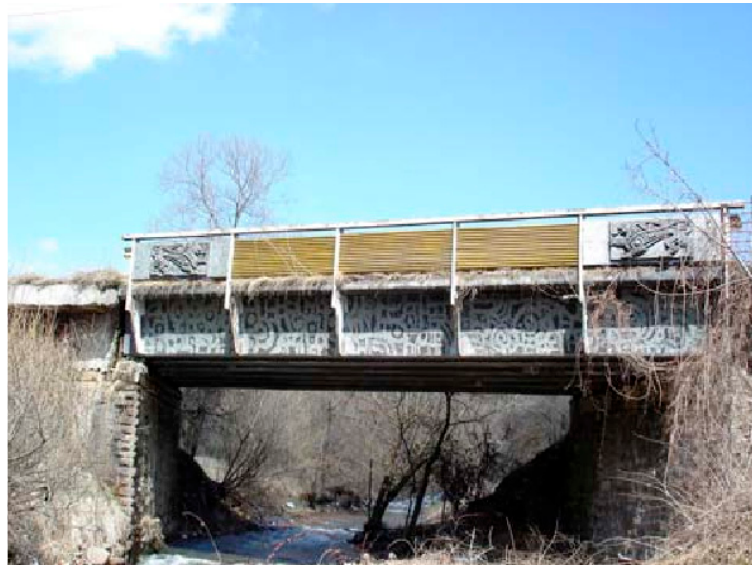
Figure 2. First FRP bridge in Ginzi, Bulgaria [40].